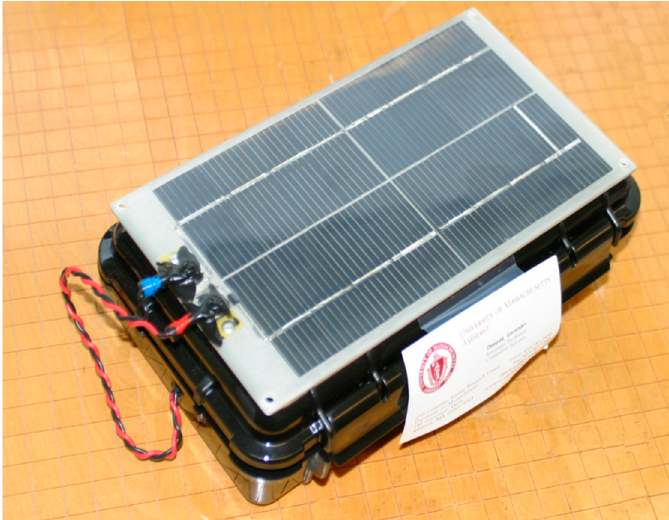
Figure 11. Measurement node using a photovoltaic panel [34].